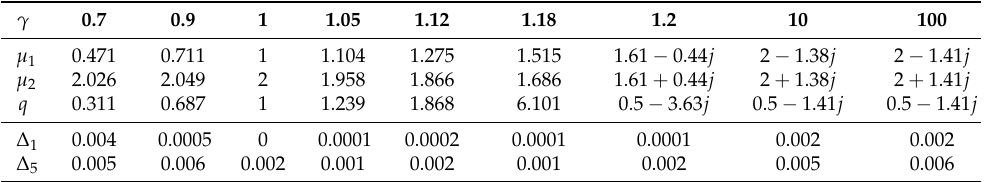
Table 2. Values of parameters µ 1 , µ 2 , and q of the hyperexponential approximation obtained for Weibull distribution function for various values of its parameter γ , and corresponding Kolmogorov distances ∆ for the main result.